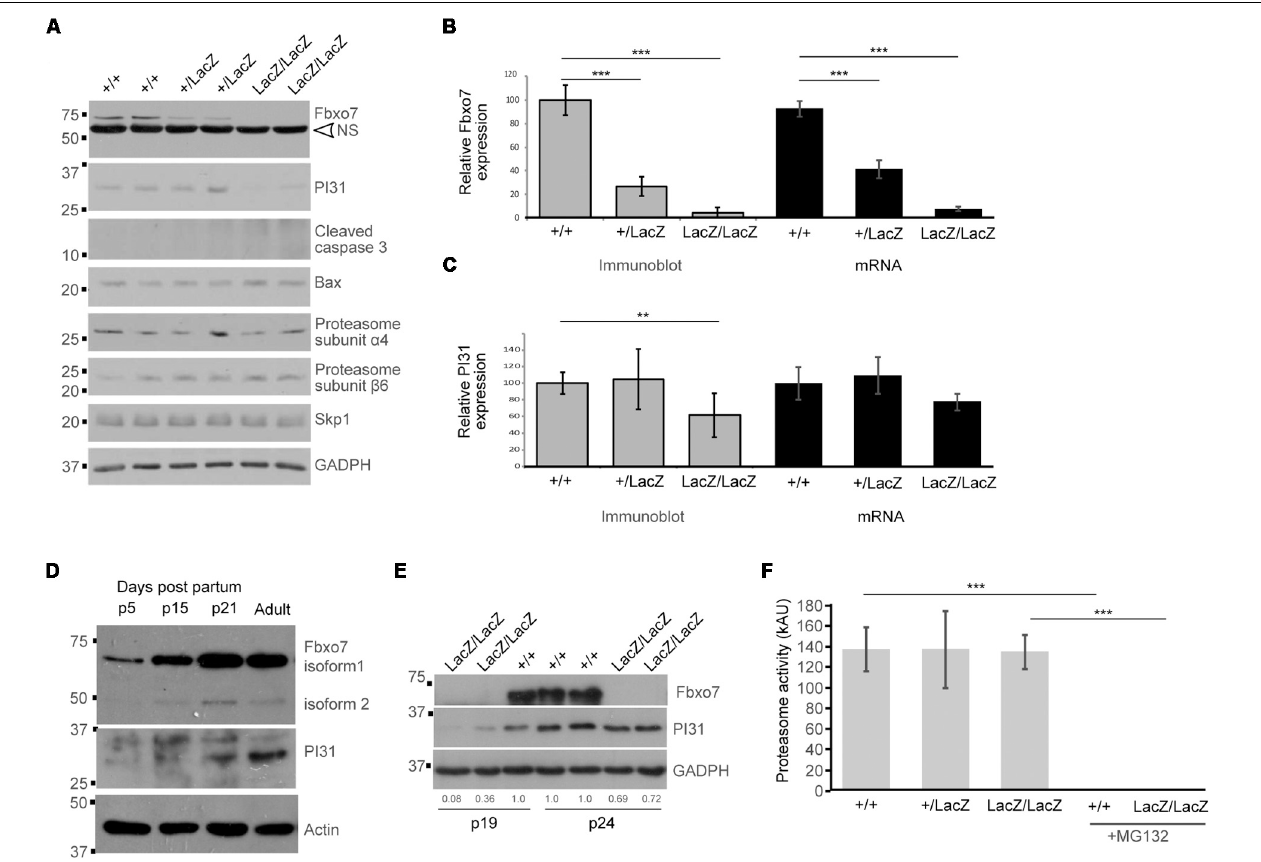
FIGURE 4 | Decreased PI31 levels but normal proteasome activity in Fbxo7LacZ/LacZ testis. (A) Immunoblot analysis for various proteins in whole testes lysates from WT, heterozygous, and homozygous LacZ mice at 8.1 weeks of age, as indicated. NS = non-specific band in Fbxo7 (Santa Cruz Biotechnology, sc-271763) Western blot. (B) Quantitation of Fbxo7 expression from immunoblots, relative to GADPH loading control; gray bars; n = 10 WT, 8 heterozygous, 7 homozygous LacZ mice. RT-qPCR of Fbxo7 relative to three housekeeping genes (cyclophilin, GAPDH, and actin); black bars; n = 4 for each genotype). Images were analyzed in ImageJ. ∗∗∗ p < 0.001 One-way ANOVA with Dunnett’s multiple comparisons test. (C) Quantitation of PI31 expression from immunoblots, relative to GADPH loading control; gray bars; n = 10 WT, 8 heterozygous, 7 homozygous LacZ mice. RT-qPCR of Psmf1/PI31 relative to three housekeeping genes (cyclophilin, GAPDH, and actin); black bars; n = 4 for each genotype). Images were analyzed in ImageJ. ∗∗ p < 0.01 One-way ANOVA with Dunnett’s multiple comparisons test. (D) Immunoblot analysis for Fbxo7 (Laman Lab polyclonal antibody) and PI31 protein in whole testes lysates from mice harvested at the indicated days post-partum (p). (E) Immunoblot analysis for Fbxo7 (Santa Cruz Biotechnology, sc-271763) and PI31 protein in whole testes lysates from mice harvested at 19 and 24 days post-partum. Quantification of PI31 protein levels relative to WT GADPH levels for each sample is indicated. (F) Proteasome activity measured in whole testis extract for each genotype. Treatment with MG132 abolished the signal, confirming the specificity of the assay. n = 3 WT, 2 heterozygous, and 4 homozygous LacZ mice, each performed in triplicate ∗∗∗ p <